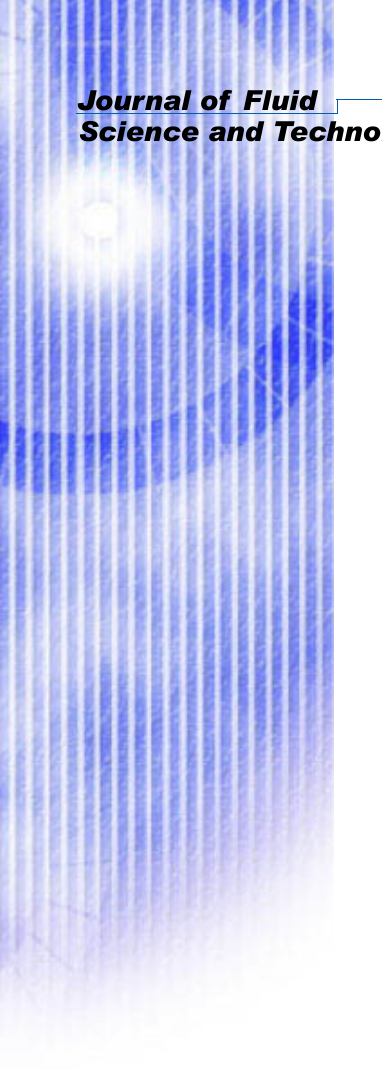
Fig. 8 Downstream variation of wake half-width and center line velocity (natural).